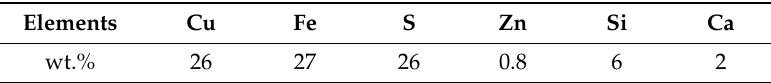
Table 1. Chemical composition of the chalcopyrite